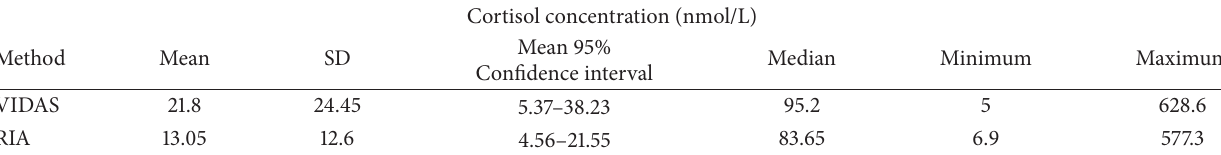
Table 1: Comparison of results obtained using the VIDAS and RIA methods for serum cortisol determination in 40 cows. Cortisol concentration (nmol/L)